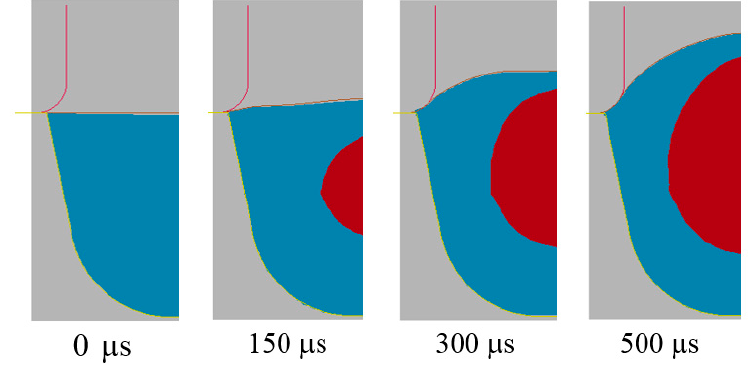
Figure 7. Blank deformation versus time during discharge.